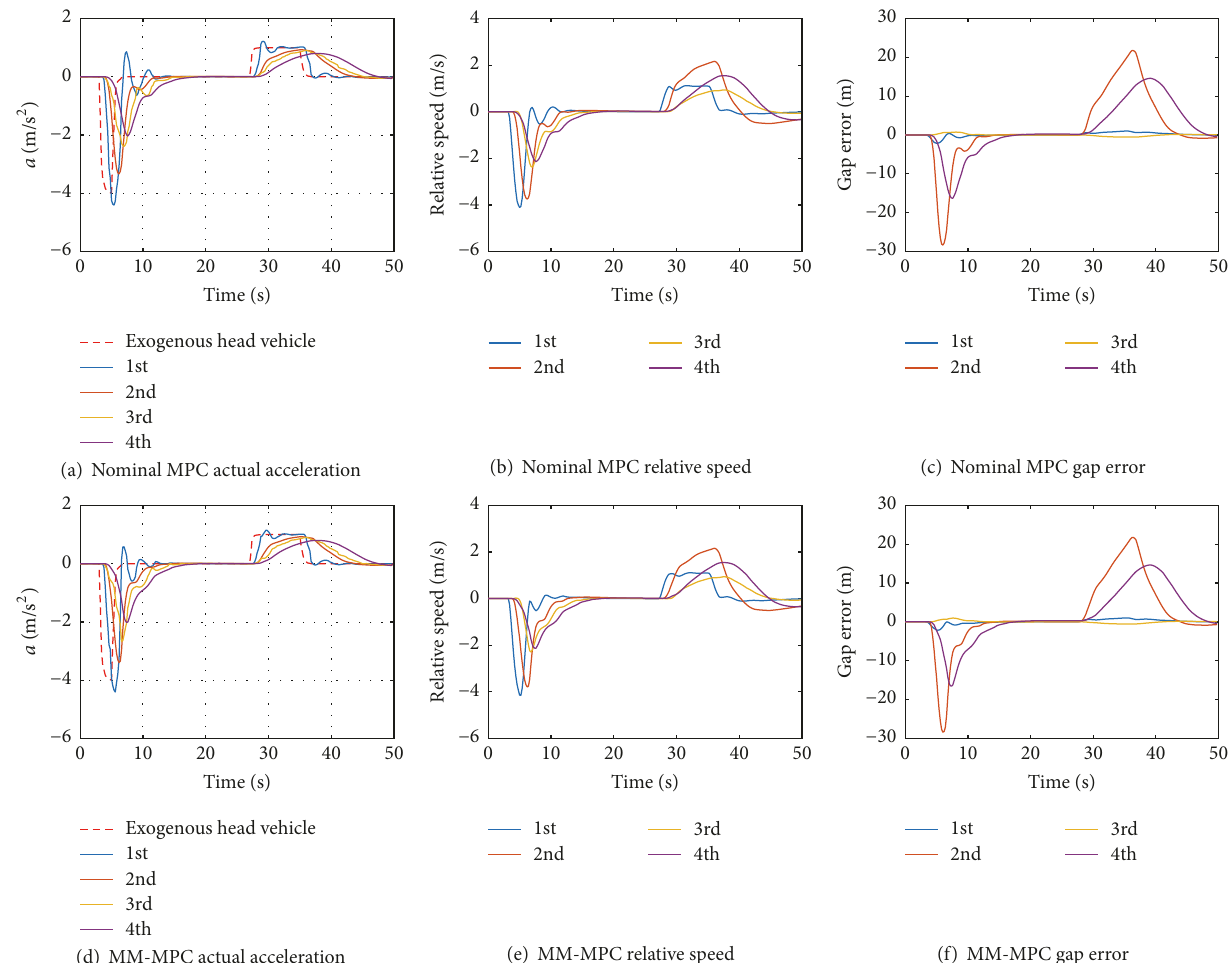
Figure 4: Comparison of nominal MPC ( 𝜏 𝐴 = 0.2 s) and MM-MPC (designed with 𝜏 𝐴 (𝑡) ∈ [0.2, 0.8] s) for heterogeneous platooning control while actual 𝜏 𝐴 (𝑡) ∈ [0.2, 0.8]